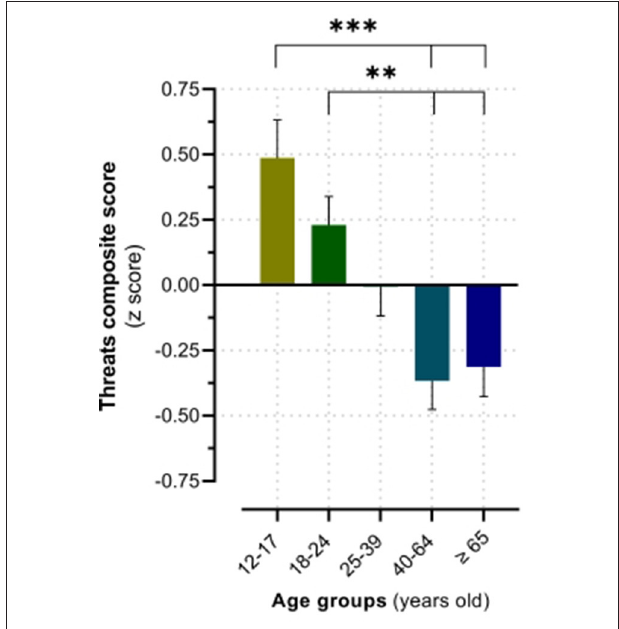
= 0.016, and a non-significant interaction p = 0.407, η 2 p between recent troubling event and age group, F (4,243) = 1.12, = 0.018, for positive emotions felt in dreams. p = 0.348, η 2 p Pairwise comparisons were not examined due to